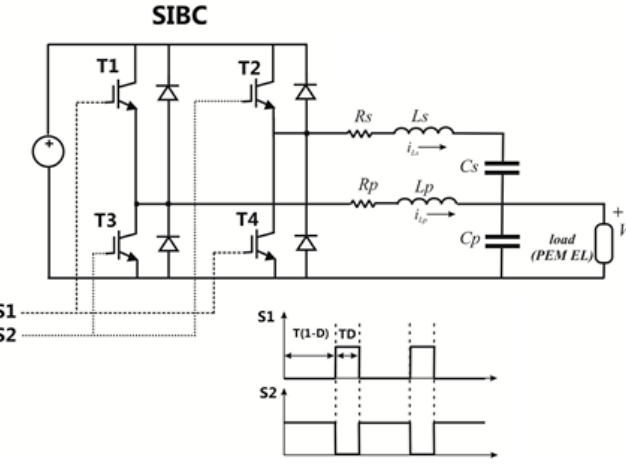
Figure 7. Electric scheme of the stacked interleaved DC–DC buck converter (SIBC).